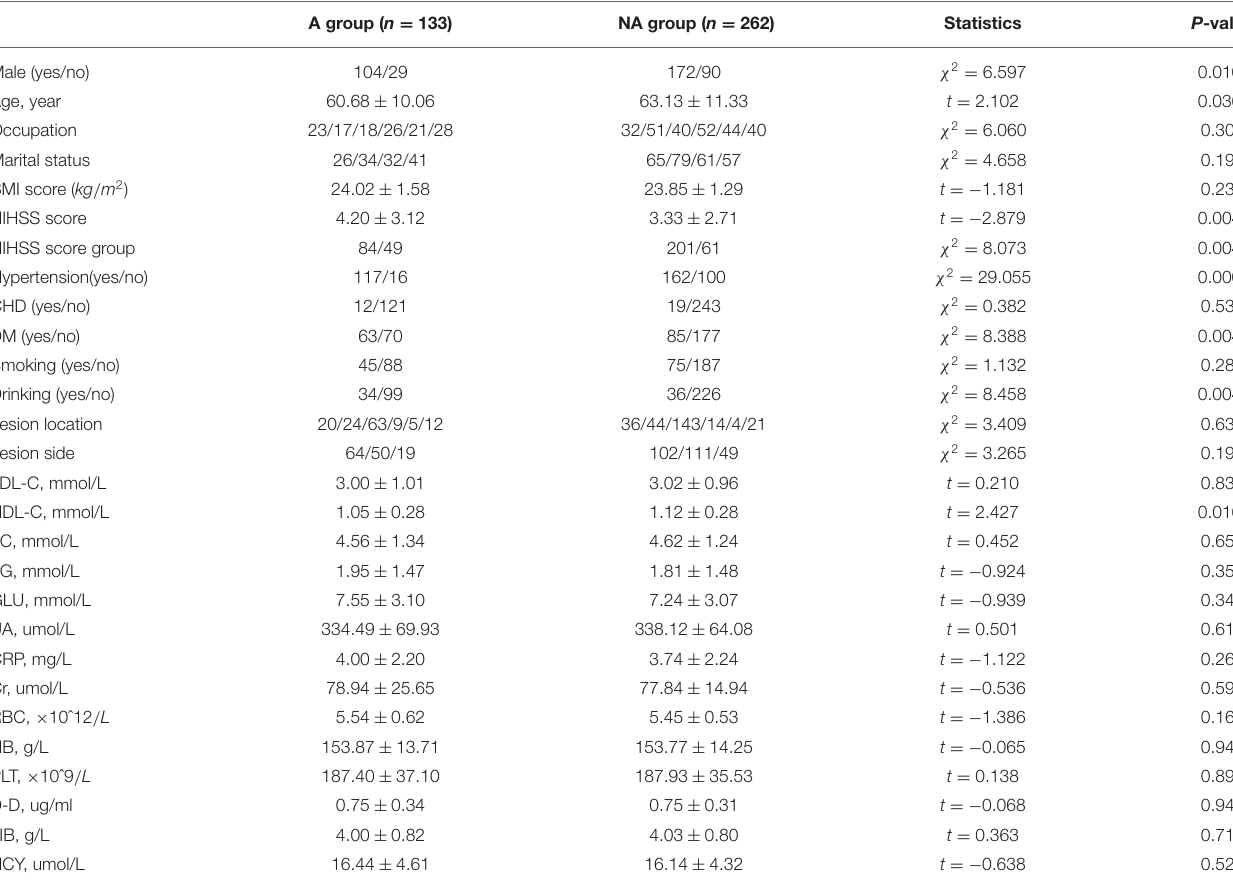
TABLE 2 | Significant characteristics between patients with and without post-stroke anxiety (PSA) by Hamilton Anxiety Scale (HAMA) scale ( n = 395). A group ( n = 133) NA group ( n = 262) Statistics P